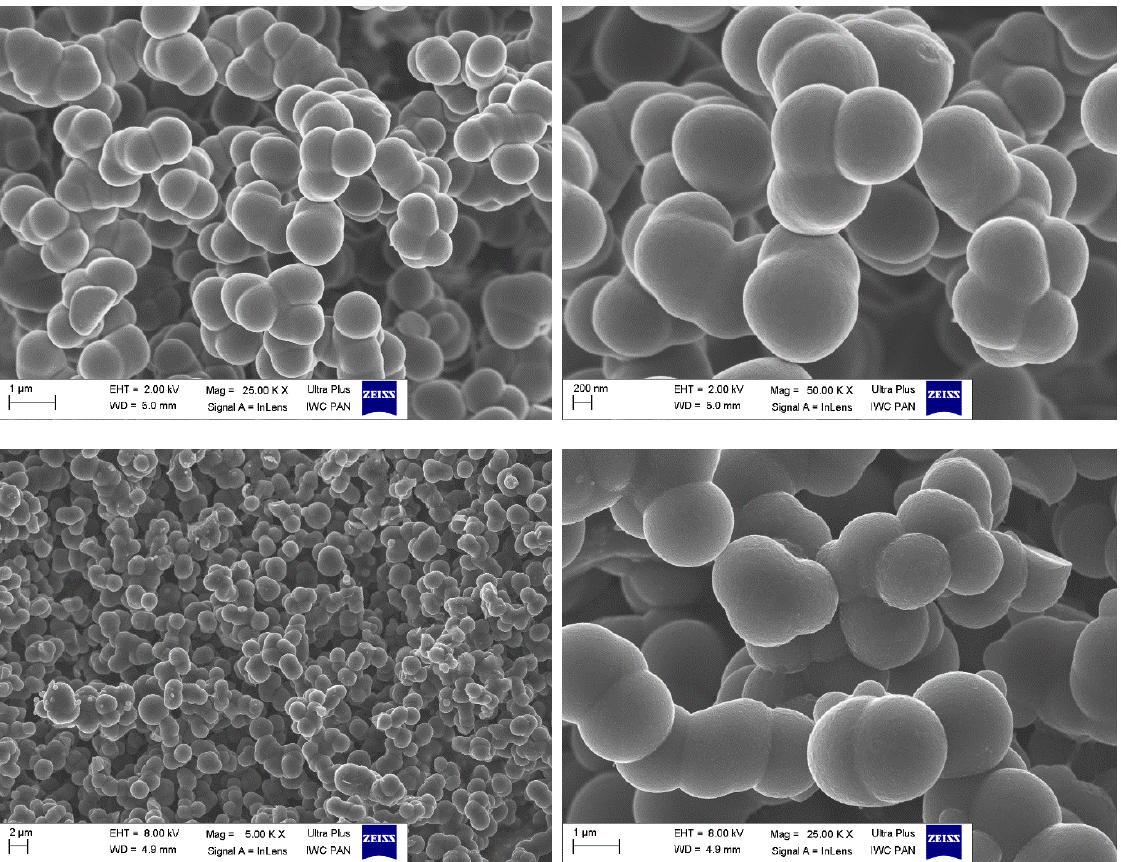
Figure 4. SEM micrographs showing the typical morphology of the sol–gel derived N (and S) co-doped carbon gels—sample CNS–950 (top row) and sample CN–950 (bottom